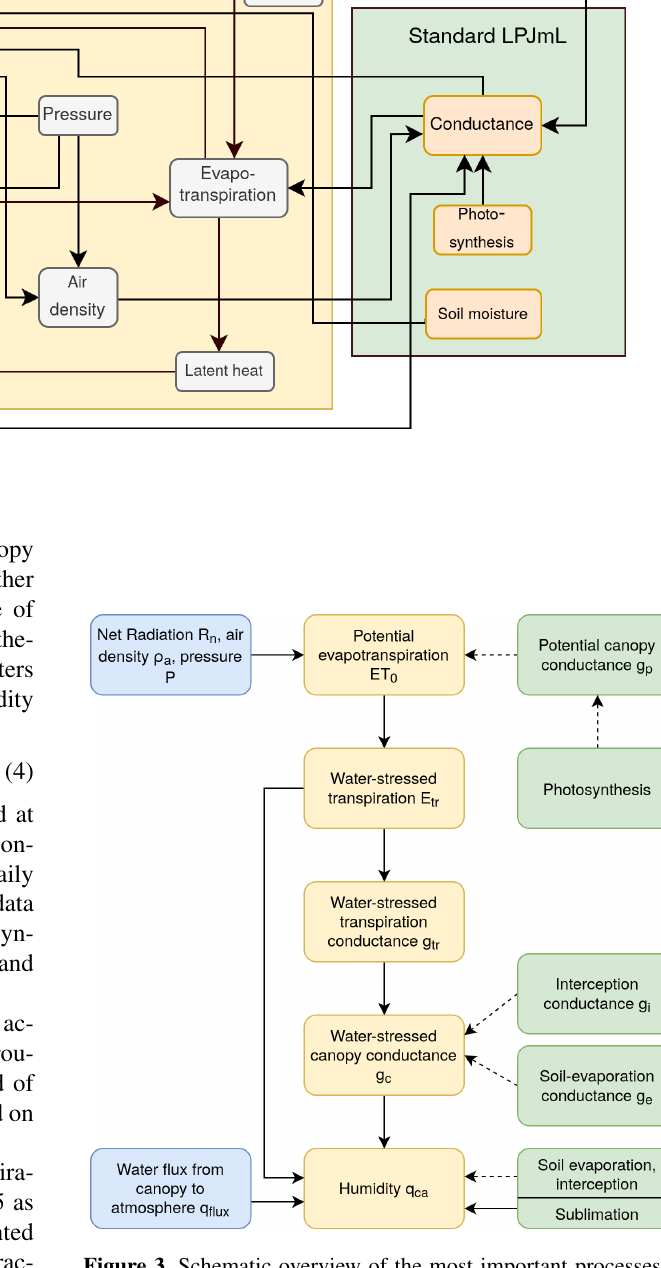
Figure 3. Schematic overview of the most important processes to determine the canopy humidity. Yellow denotes newly implemented processes in the new canopy layer in LPJmL5, green denotes inter- nal LPJmL5 calculations and blue denotes input, provided by the FMS coupler. Daily processes are indicated by a dotted line, and processes operating at a sub-daily time step are shown using a solid